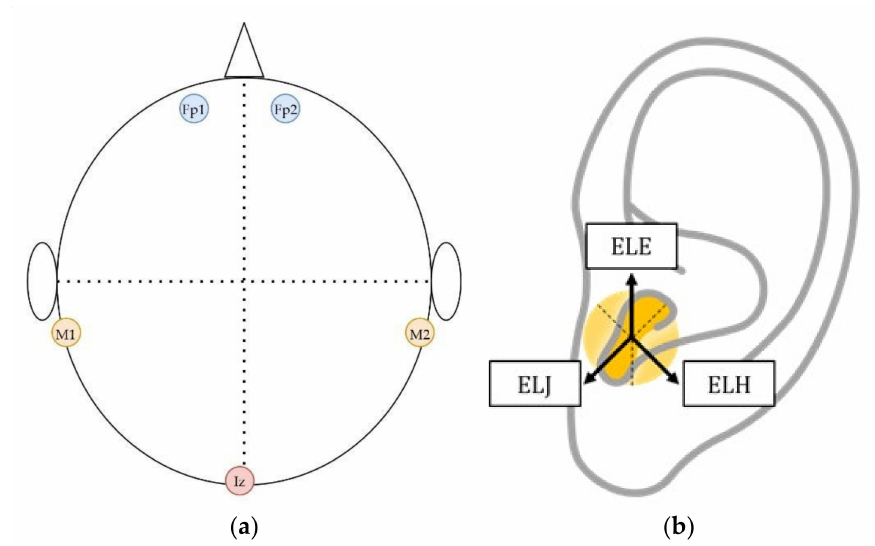
Figure 2. ( a ) Electrode placement on the head for EEG measurement according to 10–20 International electrode placement, Fp1 and Fp2 refer to forehead locations, M1 and M2 are mastoids and Iz is inion; ( b ) labeling scheme for the in-ear electrodes, Exy where x ∈ {L, R} refers to the left or right ear and y is the position of the electrodes.